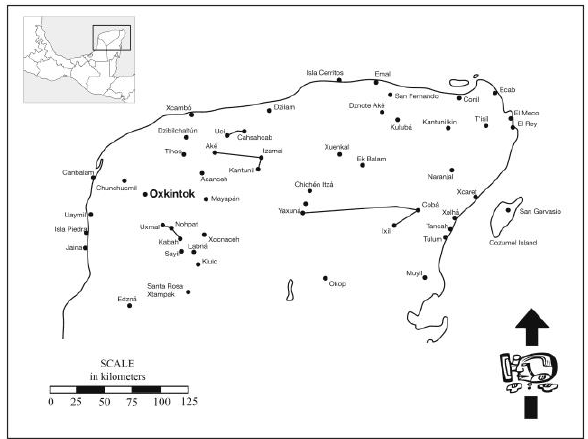
Figure 1. Archaeological site map of the northern Yucatan Peninsula, with Oxkintok indicated (J.B. Glover)